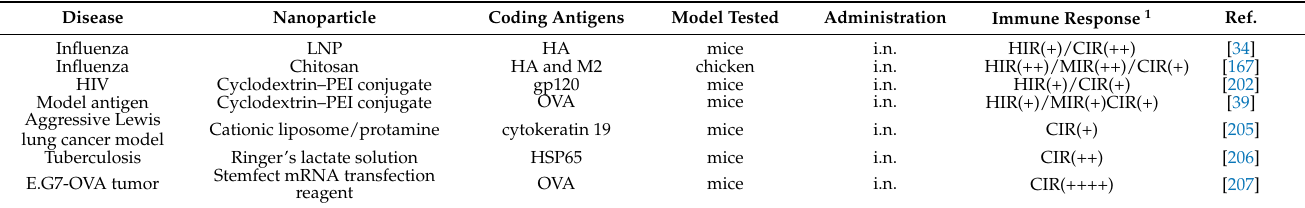
Table 3. Summary of RNA vaccines inoculated via the respiratory